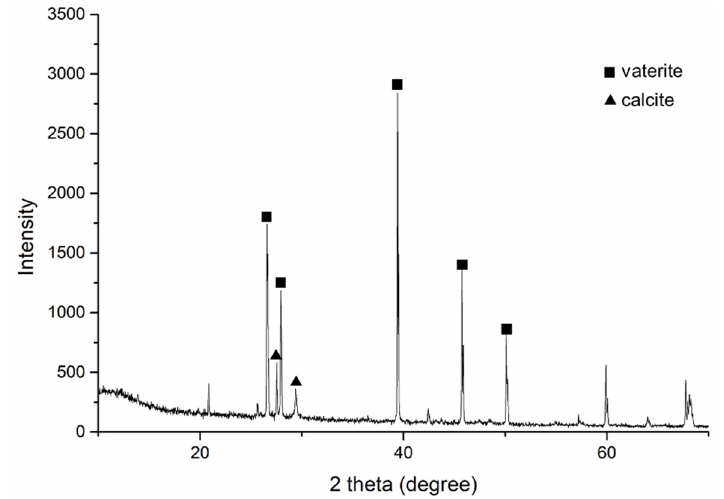
Figure 7. XRD figure of the sample treated with the optimized